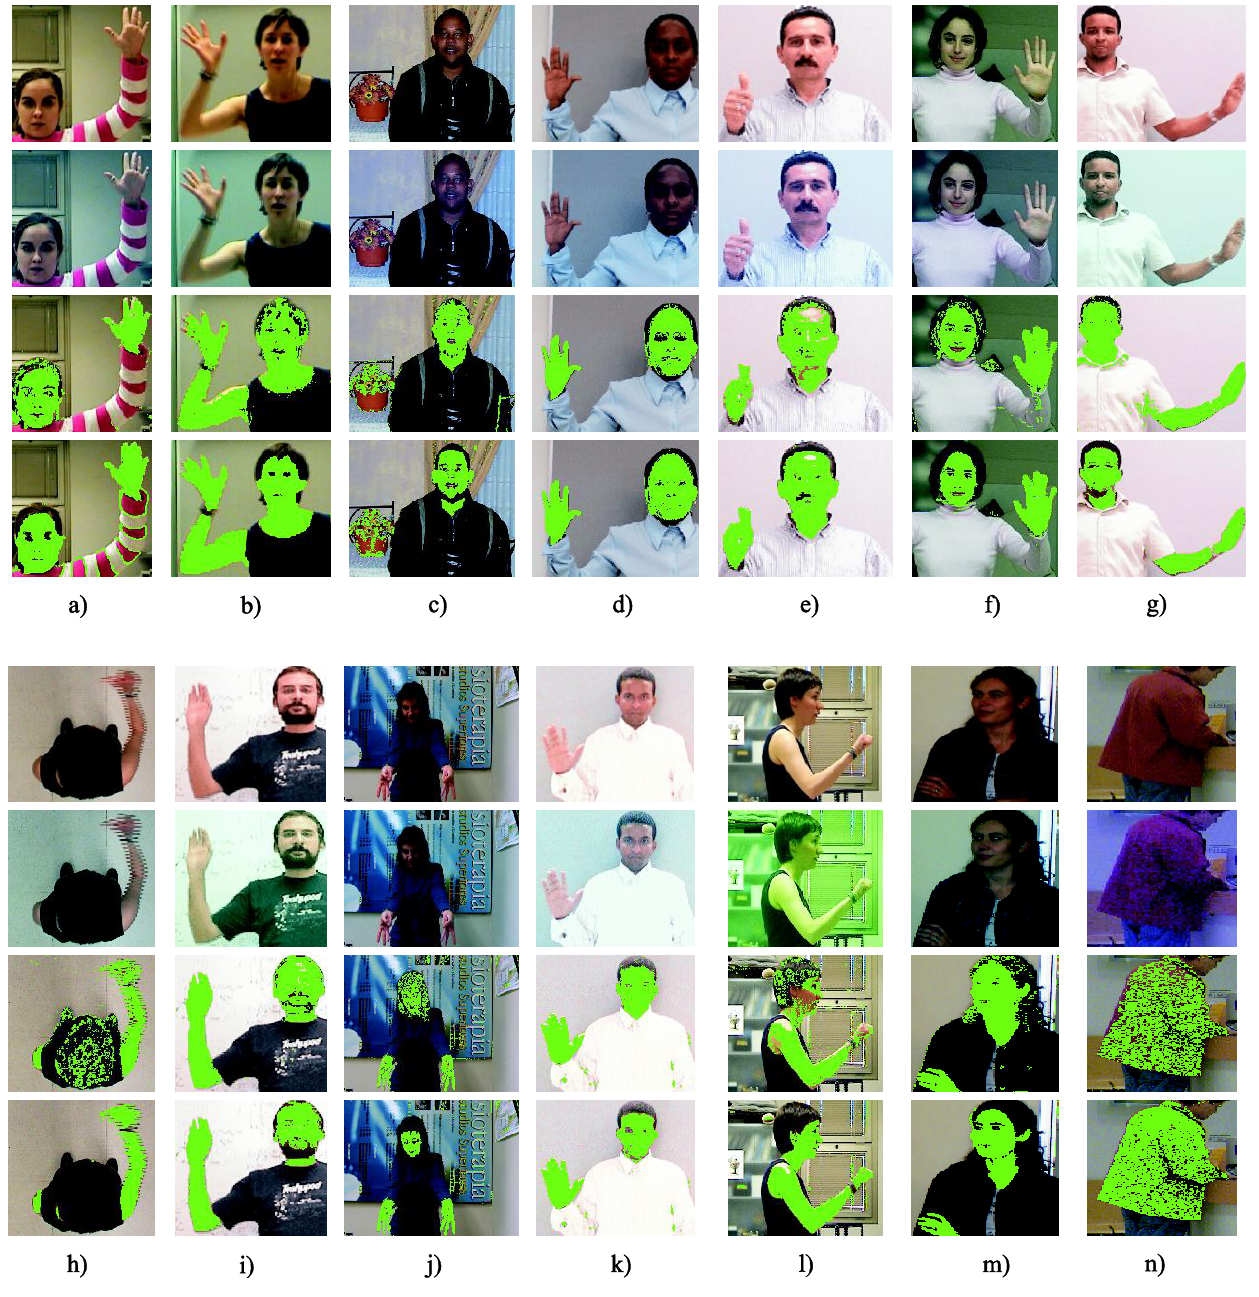
Figure 15. Segmentation results for objects in different